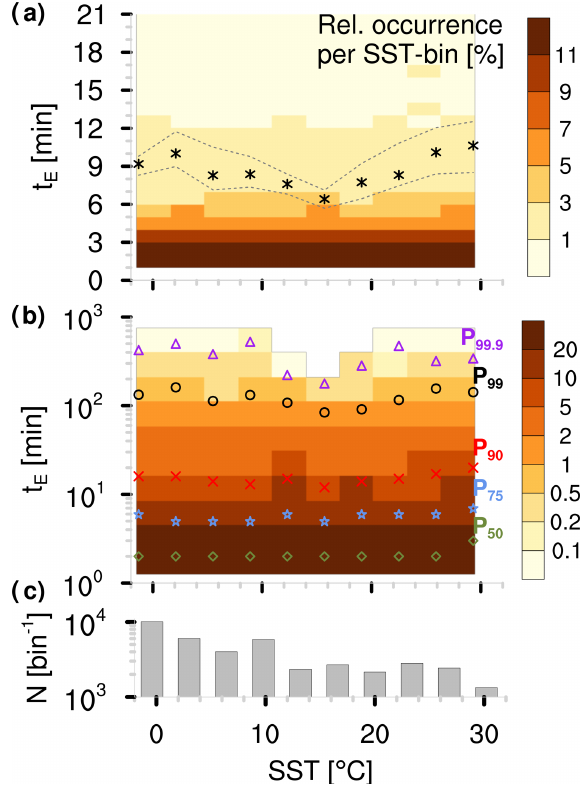
Figure 7. Two-dimensional histograms as a function of precipita- tion event duration t E (min) and OceanRAIN SST ( ◦ C) for (a) lin- ear and (b) logarithmic ordinate. Colors indicate relative occurrence (%) per SST bin. Markers in (a) show mean per SST bin surrounded by minimum and maximum from resampling 100 times as a mea- sure of uncertainty. Markers in (b) show percentiles 50, 75, 90, 99 and 99.9 of t E . Panel (c) shows the number N of events per SST